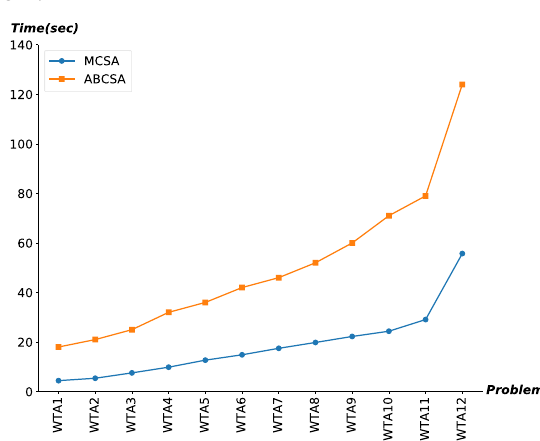
Figure 6. Time comparison between MCSA and ABC-SA for the WTA problem